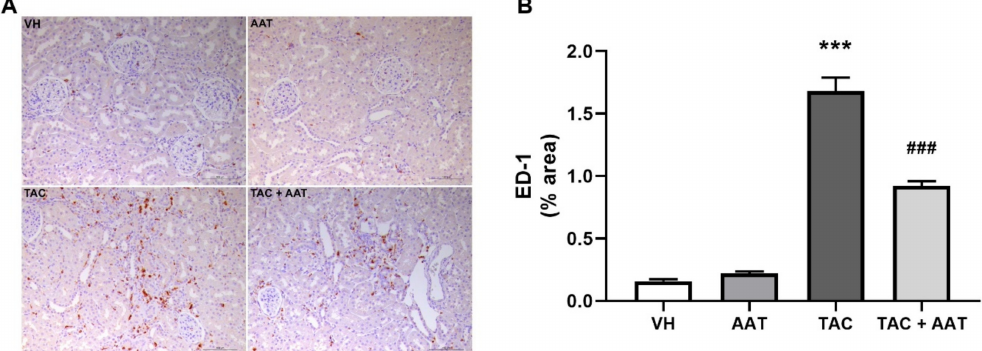
Figure 5. E ff ect of alpha-1 antitrypsin on ED-1 staining in tacrolimus-induced renal injury. ( A ) Immunohistochemical staining for ED-1 (200 × magnification). ( B ) Quantitative analysis of ED-1 staining area. Data are presented as means ± standard errors; *** p < 0.001 vs. VH; ### p < 0.001 vs. TAC. Abbreviations: VH, vehicle group; AAT, alpha-1 antitrypsin treatment group; TAC, tacrolimus treatment group; TAC + AAT, tacrolimus and alpha-1 antitrypsin cotreatment